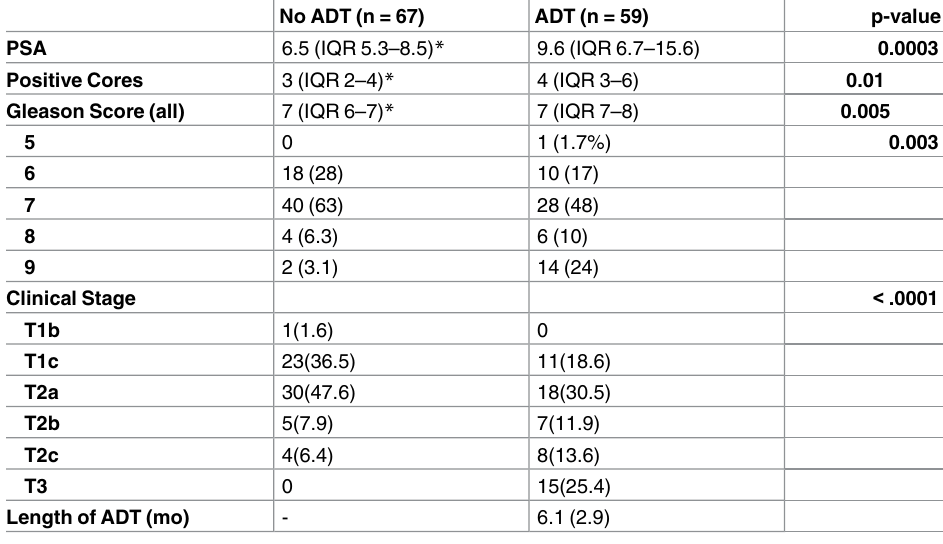
Table 1. Clinicopathologic Data at